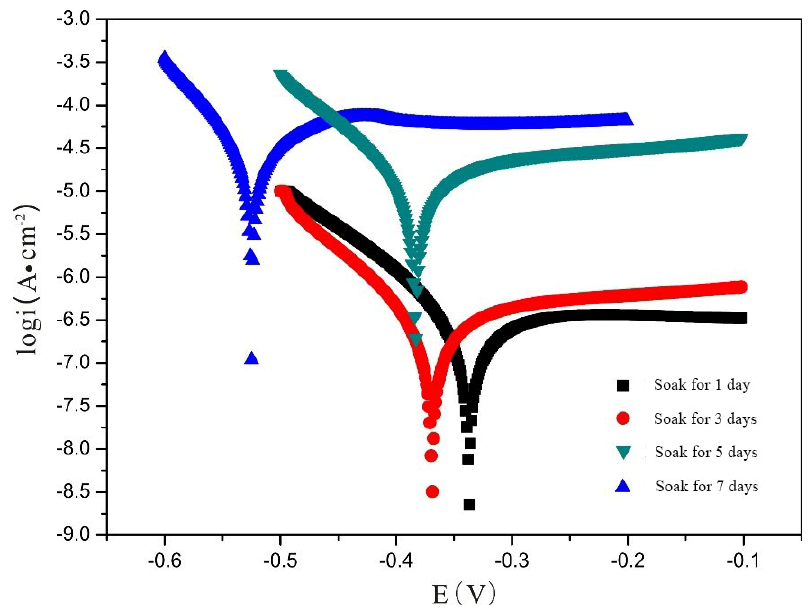
Figure 14. Tafel curves of 3D-printed + corroded samples immersed in simulated seawater for different times.